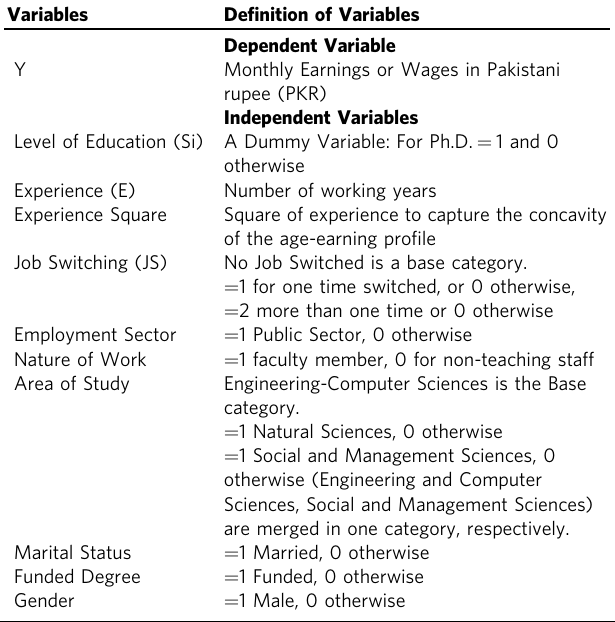
Table 3 The de fi nitions of the